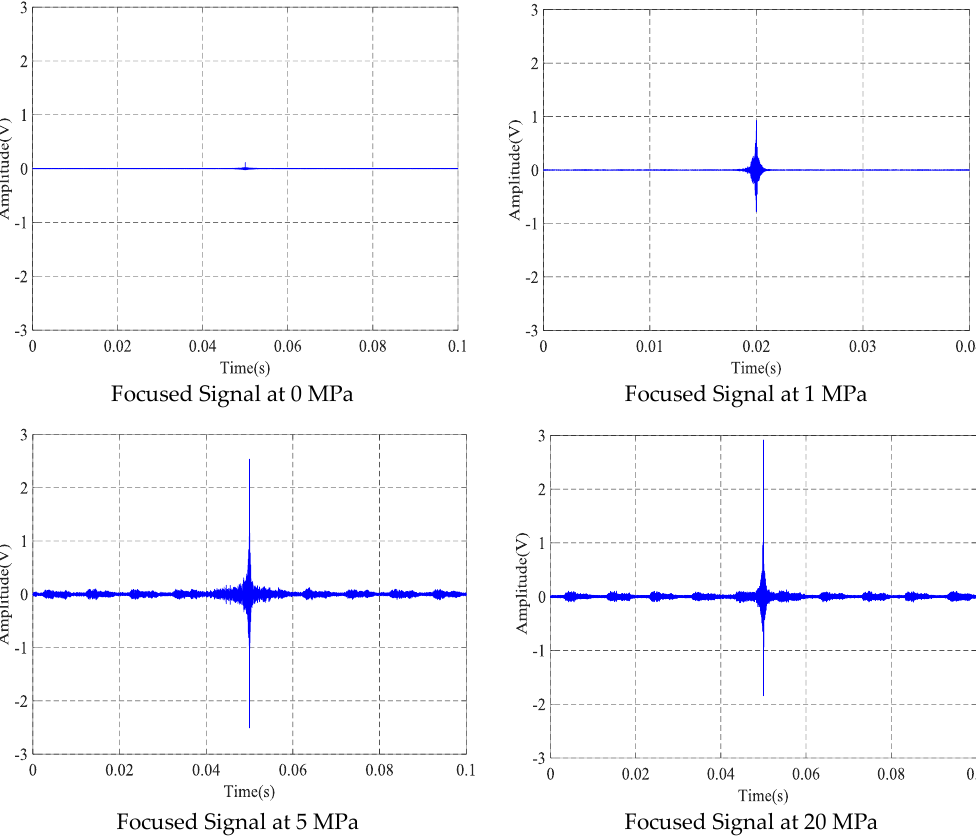
Figure 9. Focused signal based on the time reversal method at different tension levels.